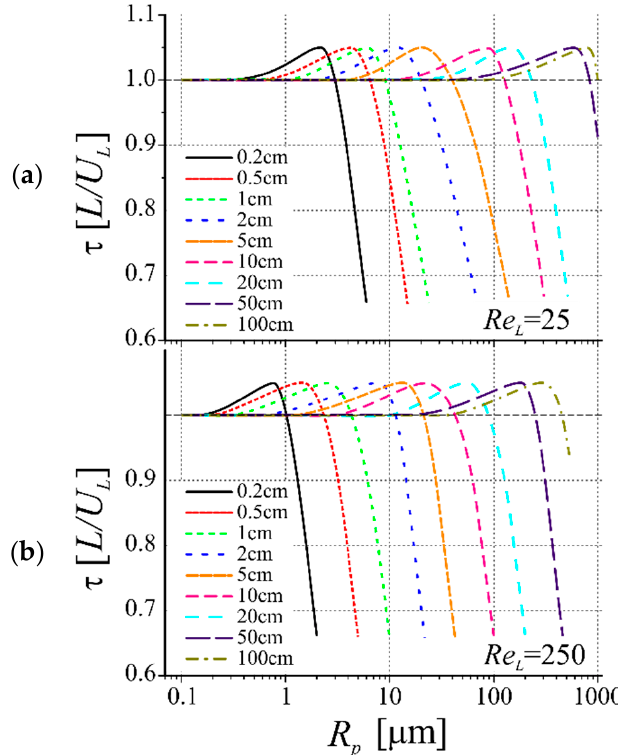
Figure 5. Residence times of the particles against the radii τ ( R p ) for various L values: ( a ) for Re L = 25 and ( b ) for Re L = 250.